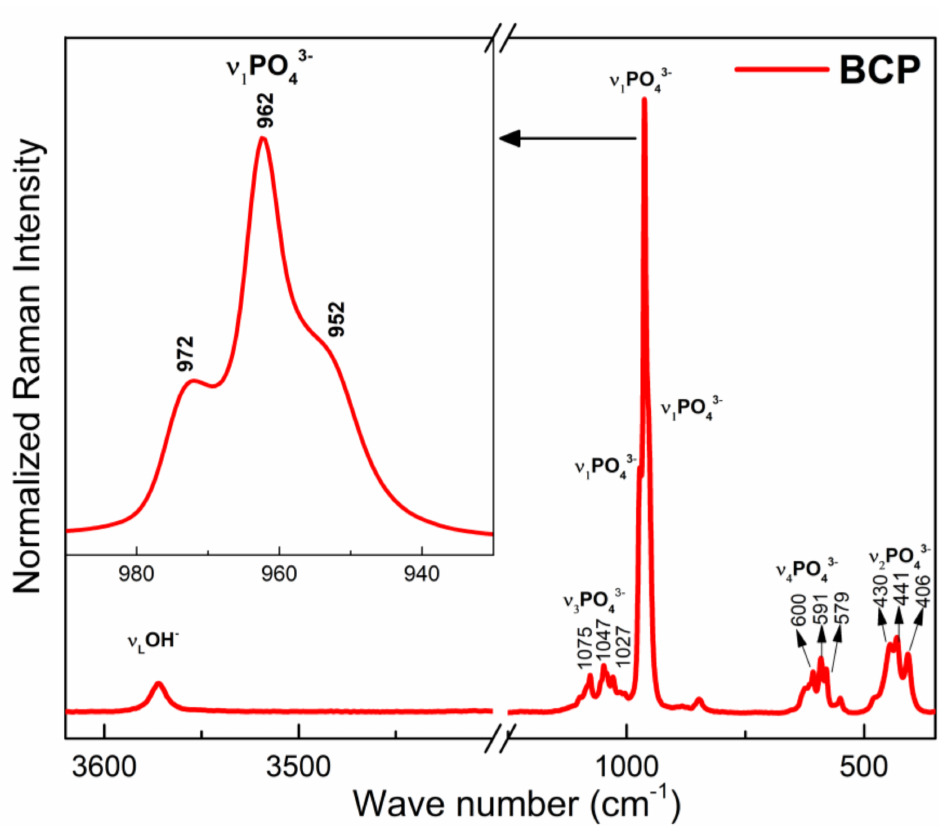
Figure 6. Raman spectra of the BCP powder obtained by calcination and milling of the fish bones. BCP = biphasic calcium